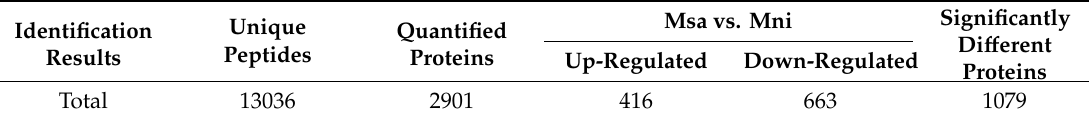
Table 1. Statistics on the protein identification results.